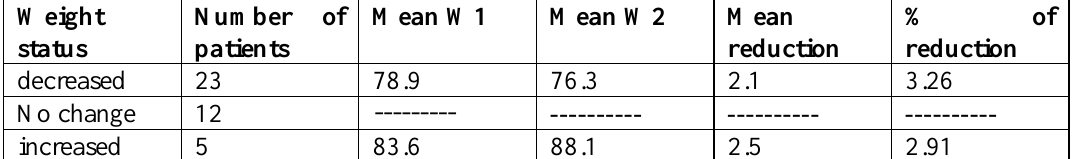
Table 7: shows the details of 9 patients with normal TSH1 and ≥ 50% reduction in TSH after metformin